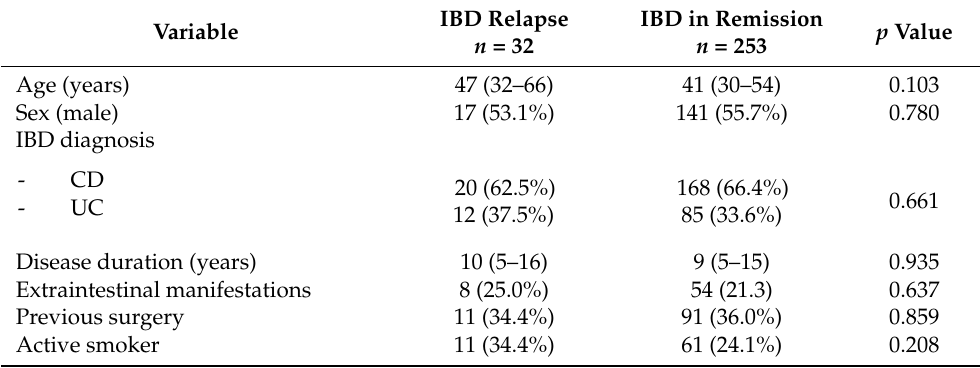
Table 2. Univariate analysis to determine factors associated with IBD